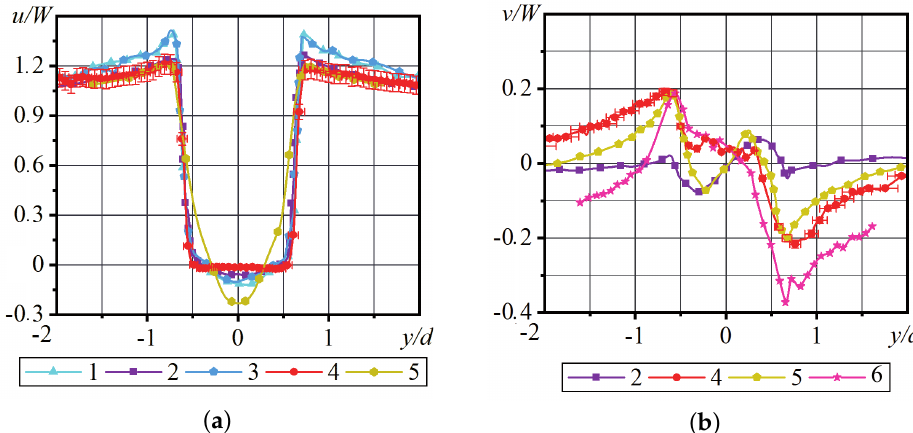
Figure 7. Profiles of the longitudinal u ( a ) and transverse v ( b ) velocity components behind the cylinder at x / d = 1.06: 1. . .4 correspond to the designations in Figure 6; 5—DNS results [8]; 6—PIV results [1].